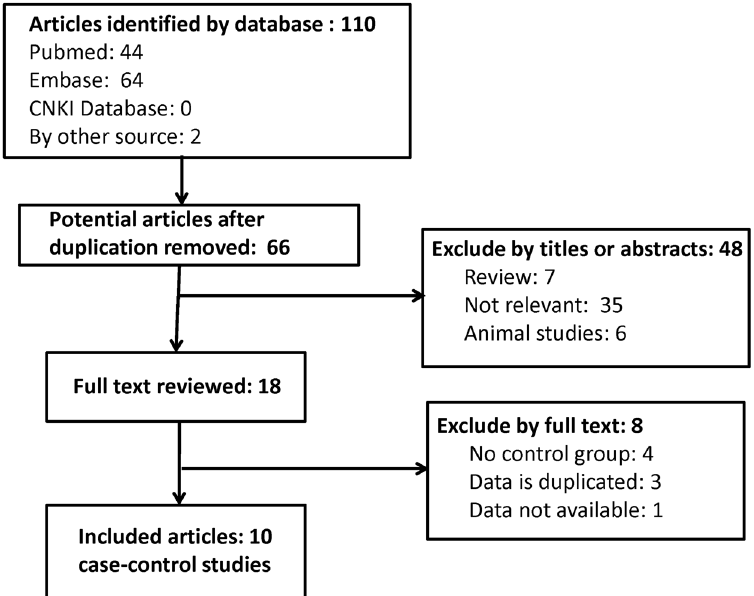
Figure 1. A flow diagram of selection process.